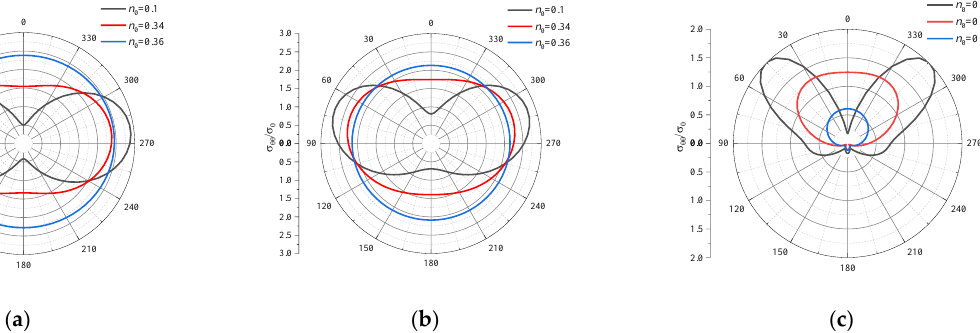
Figure 6. Effects of porosities on distributions of σ S incidence for S r = 1.0. ( k 0 is the wave number of the incident P1 wave). ( a ) k 0 a = 0.5. ( b ) k 0 a = 1.0. ( c ) k 0 a = 2.0.